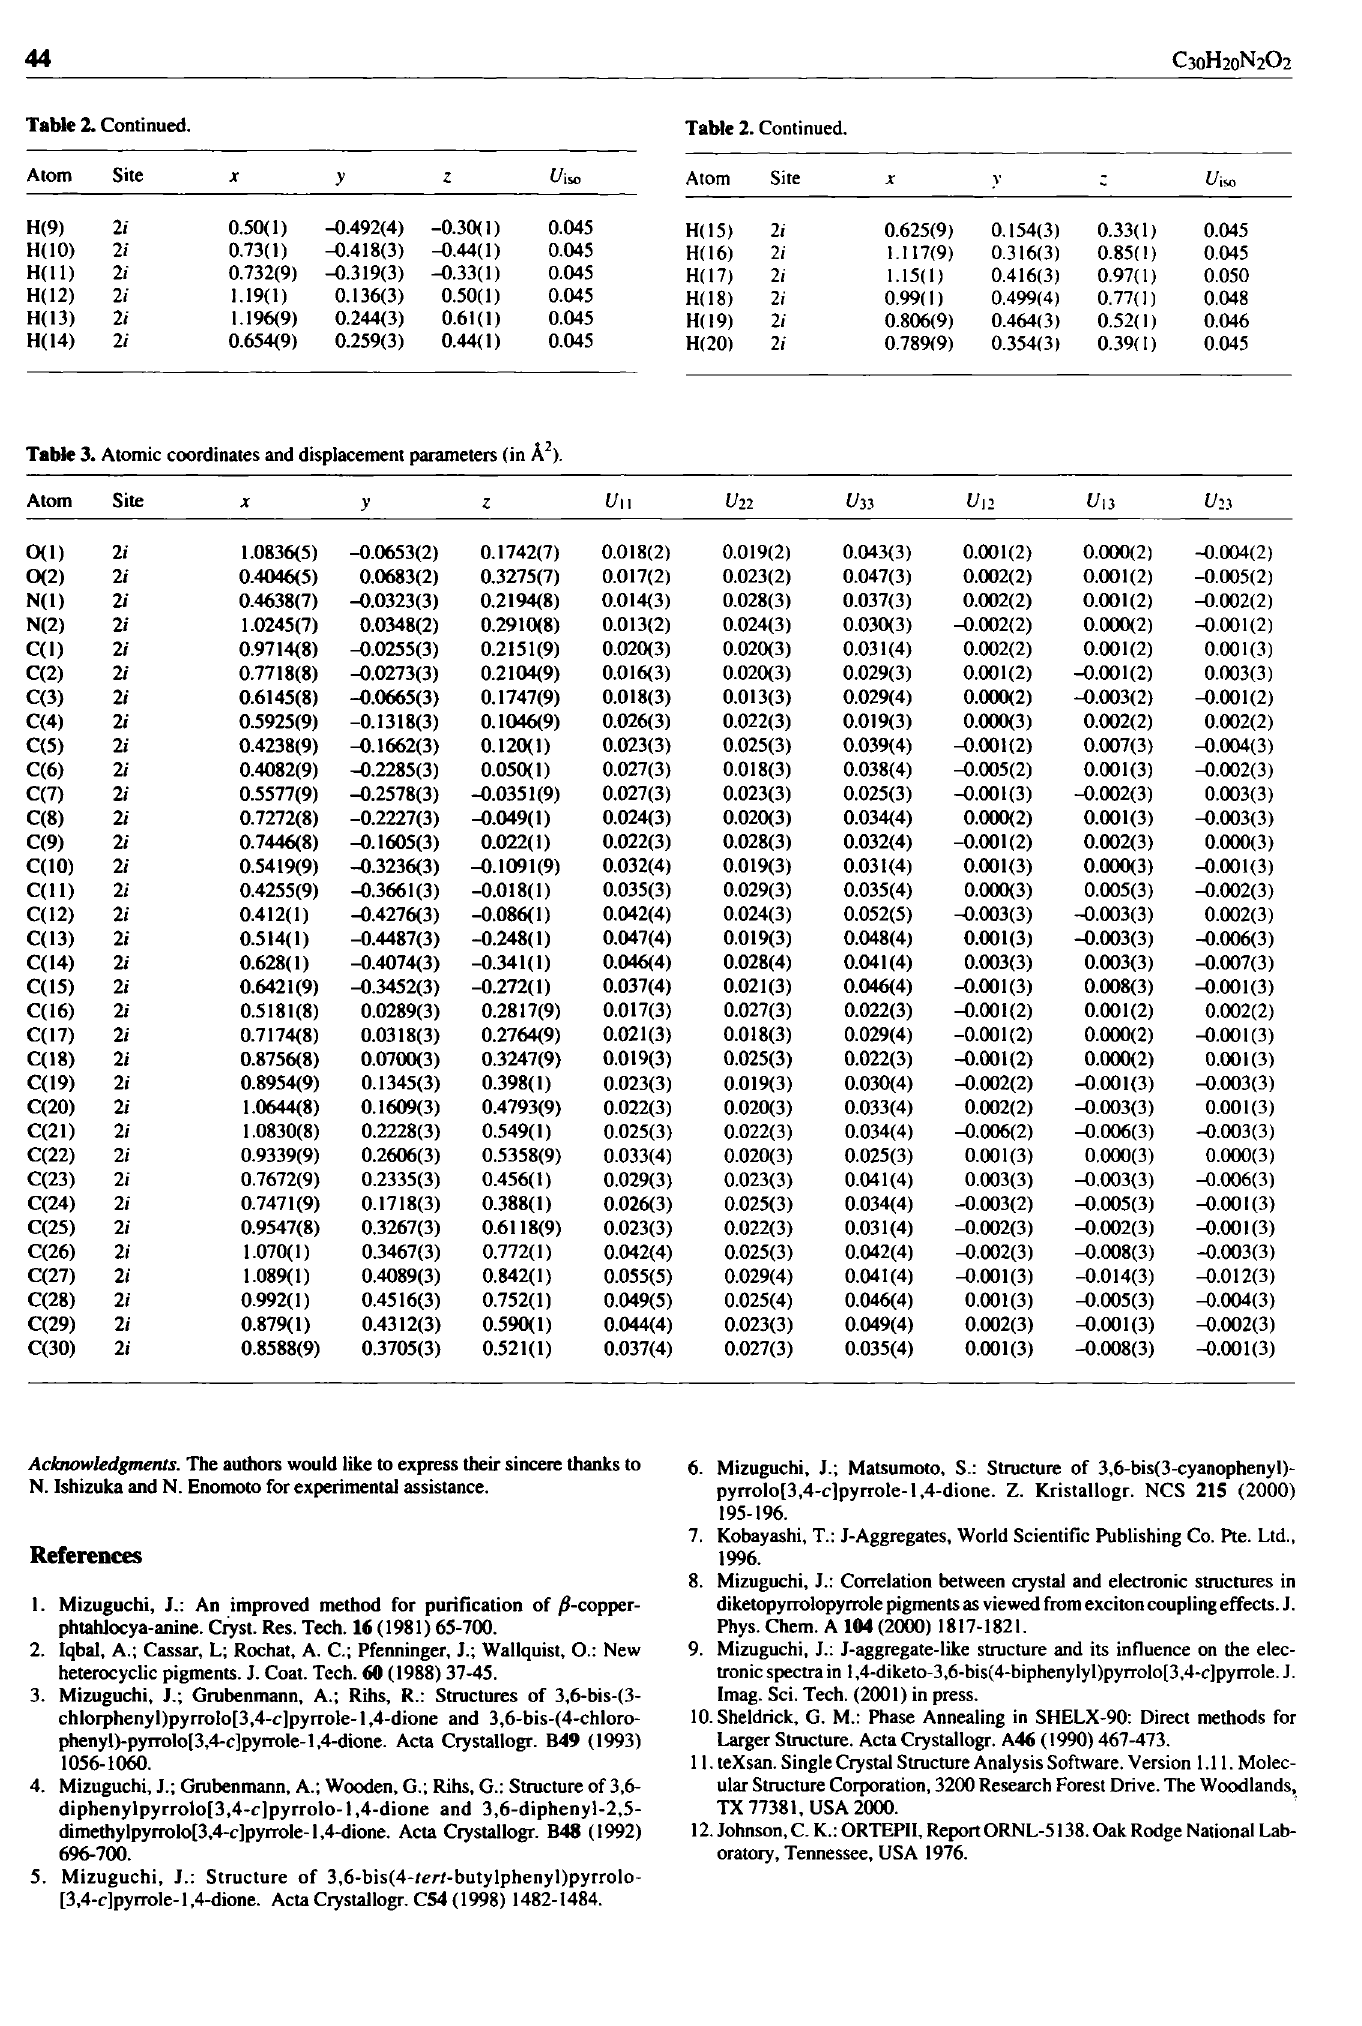
Table 3. Atomic coordinates and displacement parameters (in Â 2